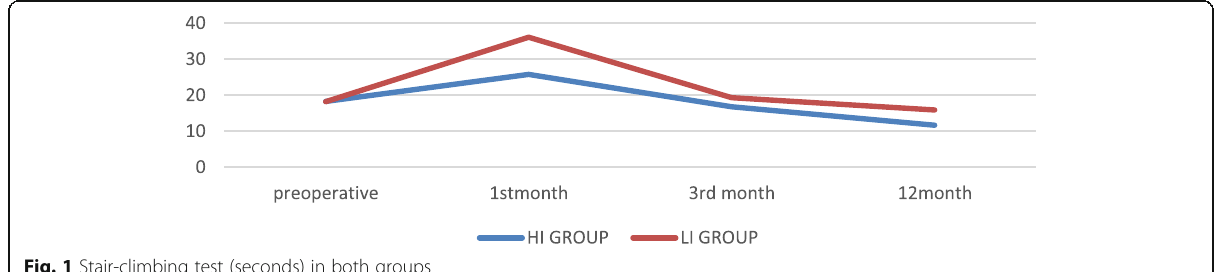
Fig. 1 Stair-climbing test (seconds) in both